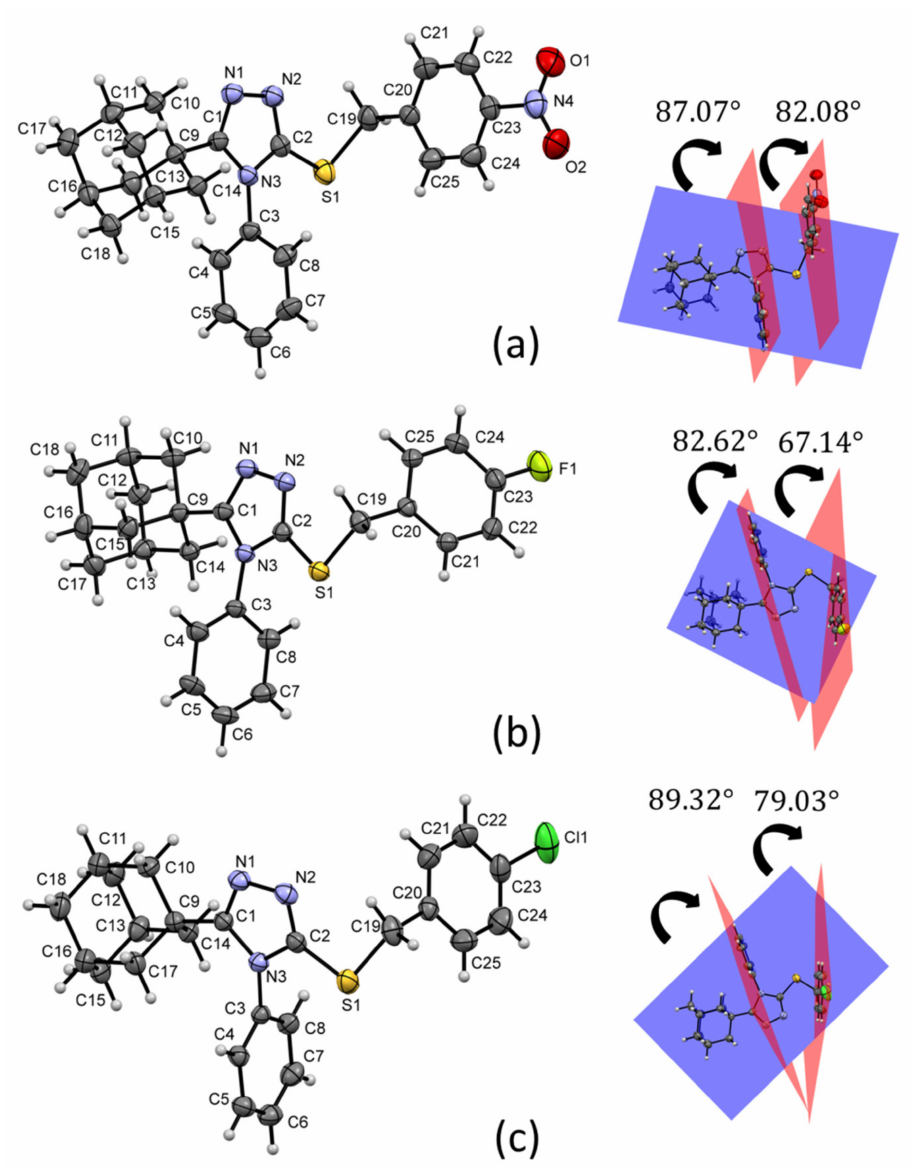
Figure 3. Molecular structures and dihedral angles of compounds 1 ( a ), 2 ( b ) and 3 ( c ) with anisotropic thermal vibration ellipsoids drawn at the 50% probability